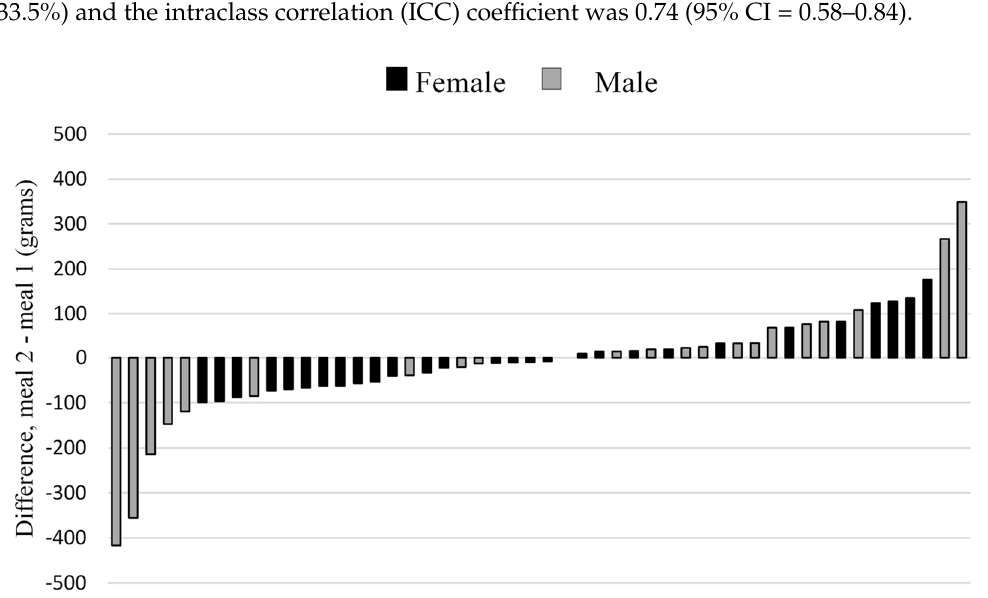
Figure 5. Individual differences in recorded food intake (grams) between two lunches with identical food choices in a Swedish high school ( n = 50). Black bars: female participants; Grey bars: male participants.